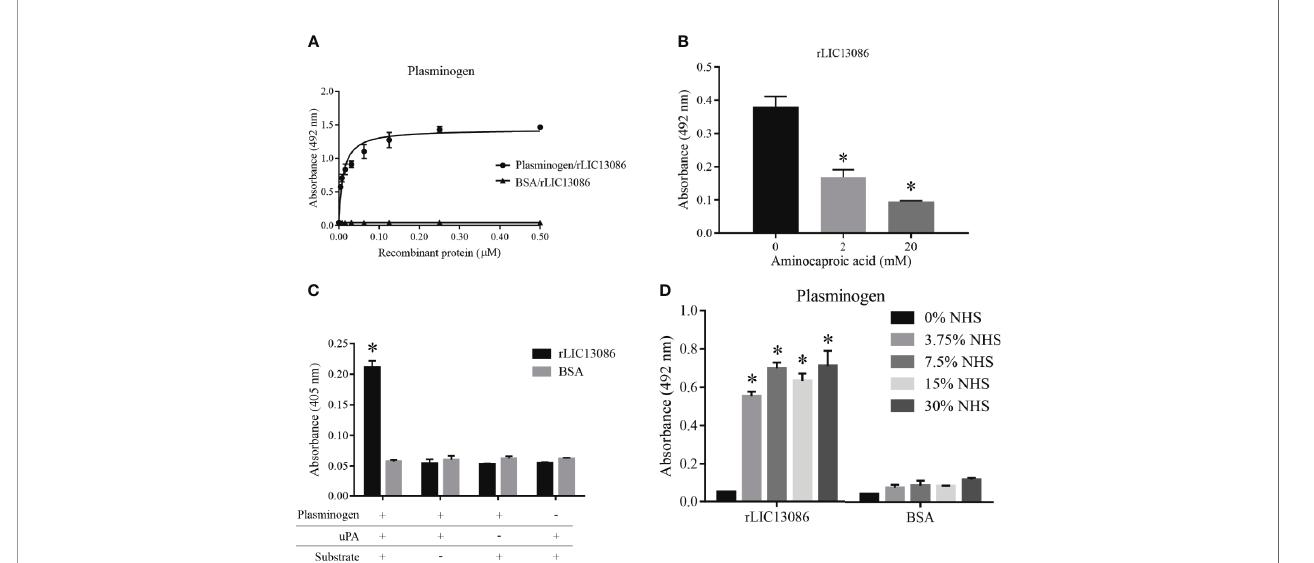
FIGURE 6 | Characterization of rLIC13086 interaction with plasminogen. (A) Coated plasminogen (1 m g) was incubated with different concentrations of rLIC13086 (0 – 0.5 m M) for 2 h at 37°C and detected with HRP-conjugated anti-HisTag mAb (1:10,000). (B) The immobilized Plasminogen was co-incubated with aminocaproic acid (0, 2, and 20 mM) and rLIC13086 (1 m g) for 2 h at 37°C. Detection was performed with HRP-conjugated anti-HisTag mAb (1:10,000). (C) Coated rLIC13086 was incubated with plasminogen, uPA, and the chromogenic substrate D-val-leu-lys-p-nitroanilide dihydrochloride. Reactions lacking one of each component were used as controls. (D) rLIC13086 was immobilized and incubated with increasing concentrations of NHS. The interaction was assessed by the addition of mouse anti- human plasminogen IgG (1:10,000) followed by HRP-conjugated anti-mouse IgG (1:10,000). BSA was used as negative control. The bars represent the means of three different experiments in triplicates with the corresponding standard deviation. *Indicates signi fi cant difference calculated by Student t- test with p-values < 0.05.